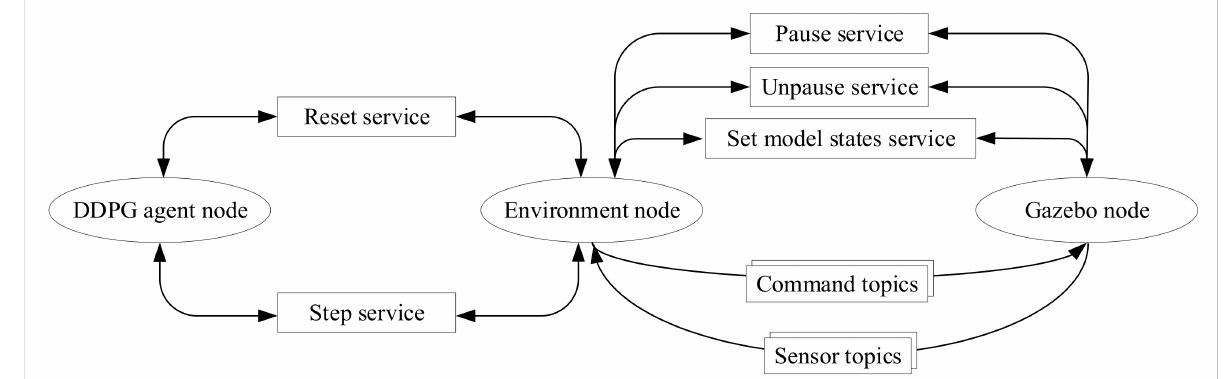
Figure 8. The computing graph of the simulation